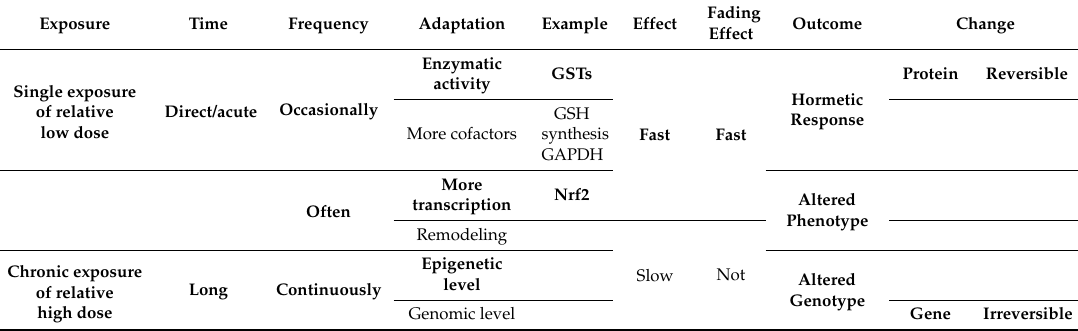
Table 2. The effect of time and frequency of exposure on adaptive changes. If the environment changes (for example, the O 2 pressure), the steady state will be restored directly; in the long-term the steady state will be